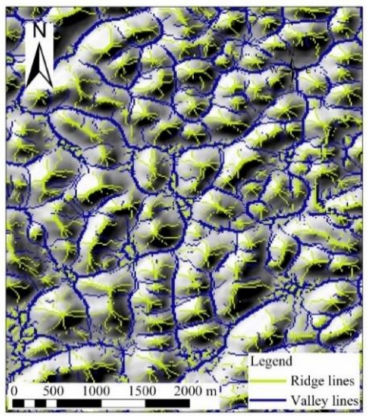
Figure 3. Ridge and valley lines in Fengcong depression